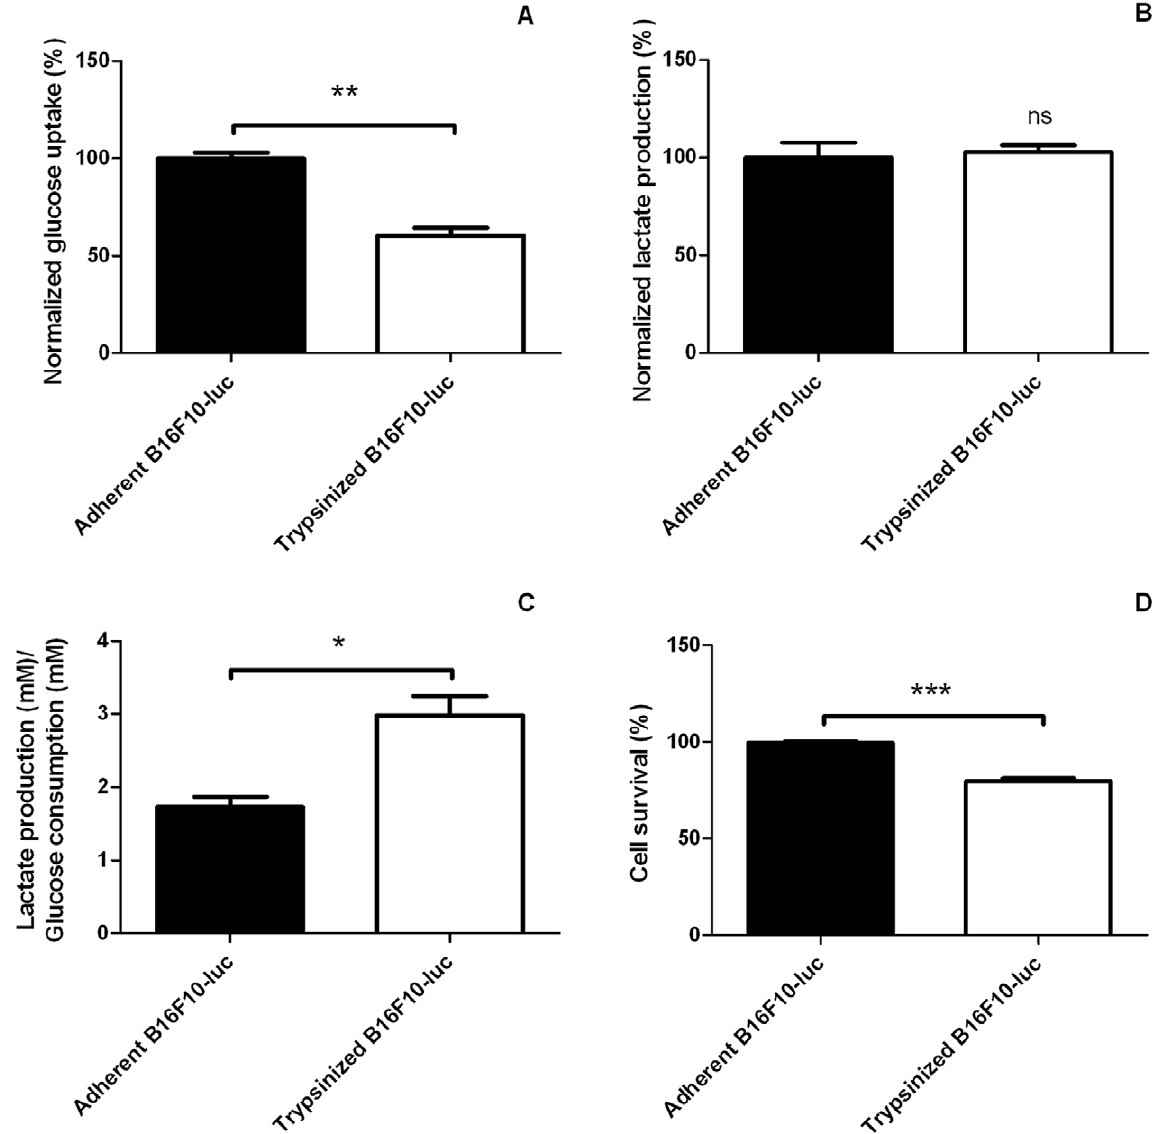
Figure 7. Glucose metabolism in adherent and trypsinized B16F10-luc. Trypsinized B16F10-luc (n=3) take up less glucose (A) and release similar amounts of lactate (B) than adherent cells (n=3). Cell detachment therefore accounts for an increased lactate production/glucose uptake ratio (C). Prolonged detachment (4 hours) affects cell survival (D). Results are statistically significant (** p , 0.01 for A, ns, p . 0.05 for B, * p , 0.05 for C, *** p , 0.001 for D). Data are expressed as means 6